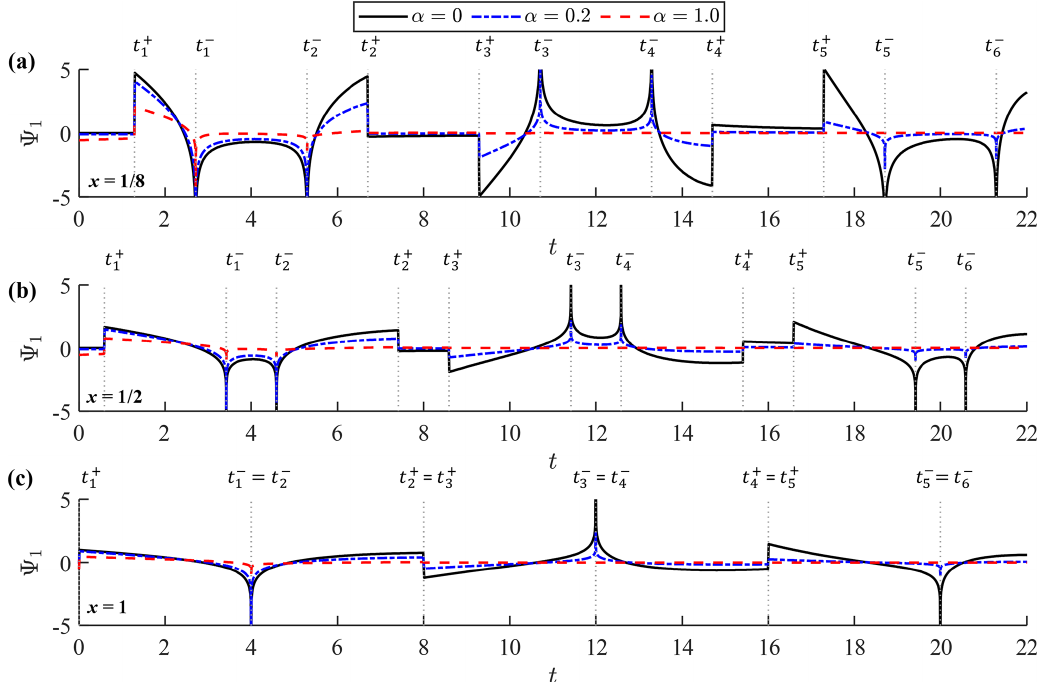
Figure 4. Function (cid:57) 1 (x,t) at (a) x = 1 / 8, (b) x = 1 / 2 and (c) x = 1. Each panel shows the graphs of the function for α = 0, α = 0 . 2 and α = 1 . 0. Vertical dotted lines represent the timing of singularities, t ± m